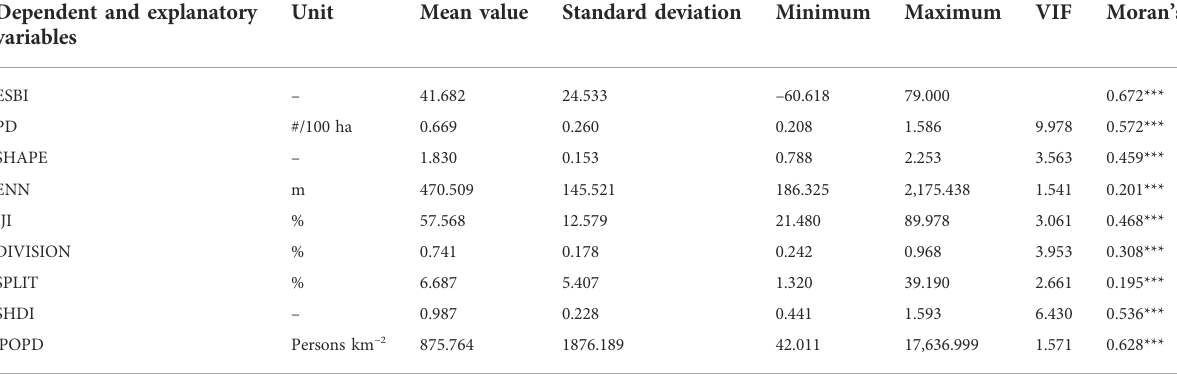
TABLE 1 Summaries of the ESBI and explanatory variables for 1980, 2000, and 2017. Dependent and explanatory